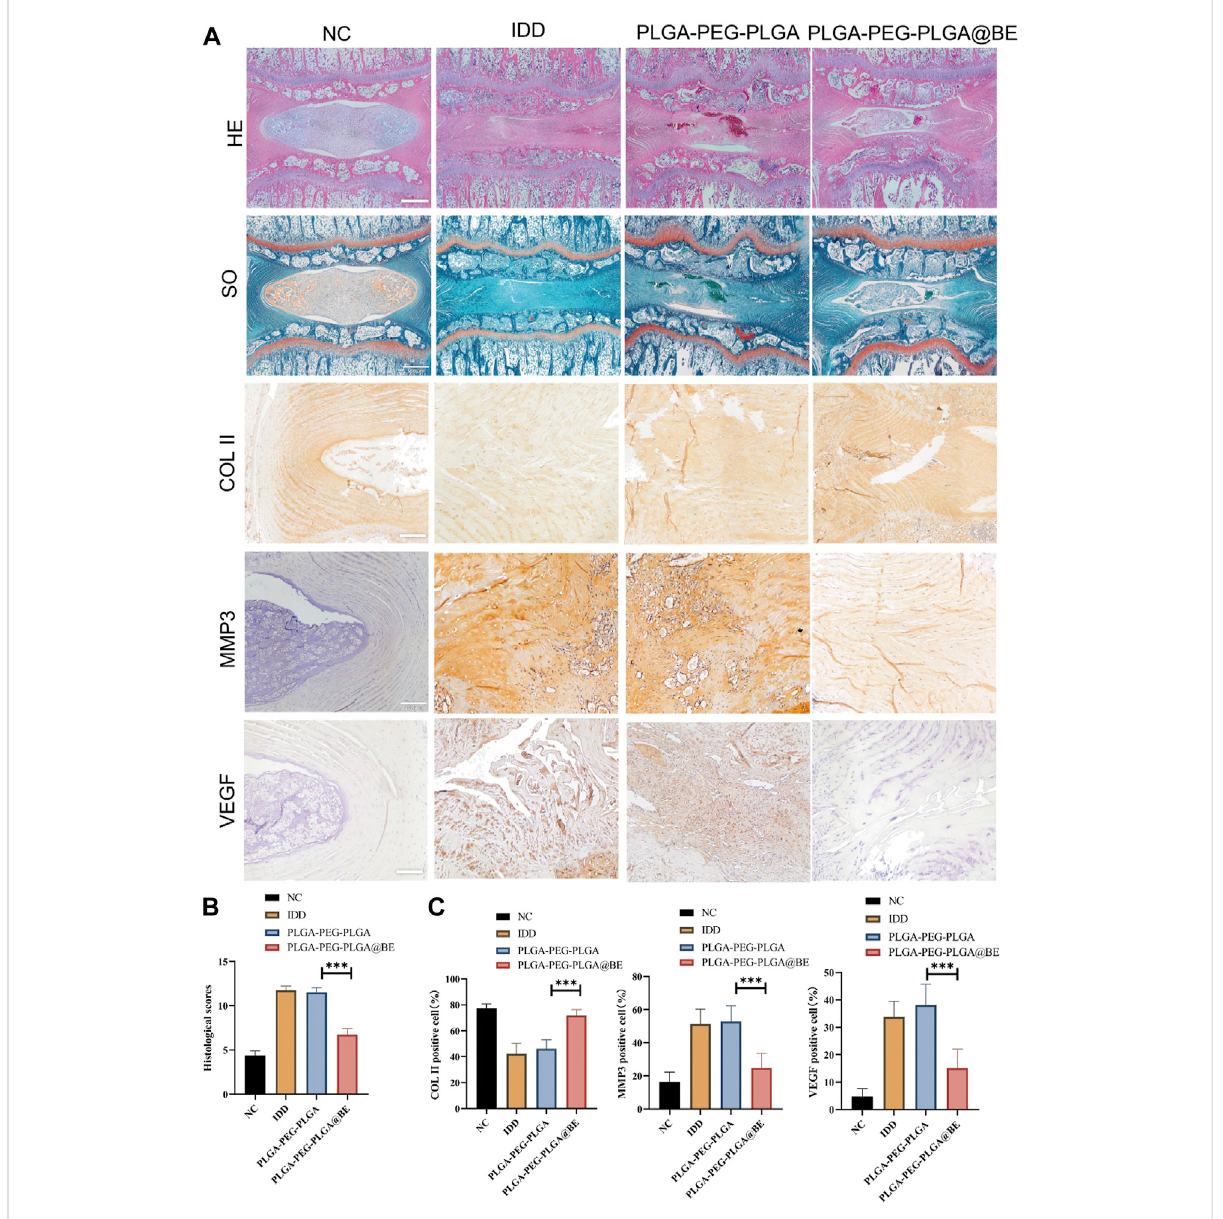
FIGURE 5 Histological assessment of rat IDD model. (A) H&E staining, SO staining, and Immunohistochemistry staining of COL II, MMP3, VEGF. (B) Histologicalgradesinweek8ineachgroup. (C)